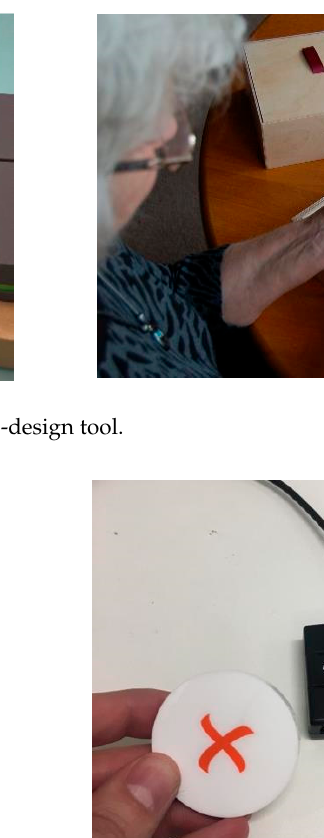
Figure 1. Exhibition in a box co-design tool.